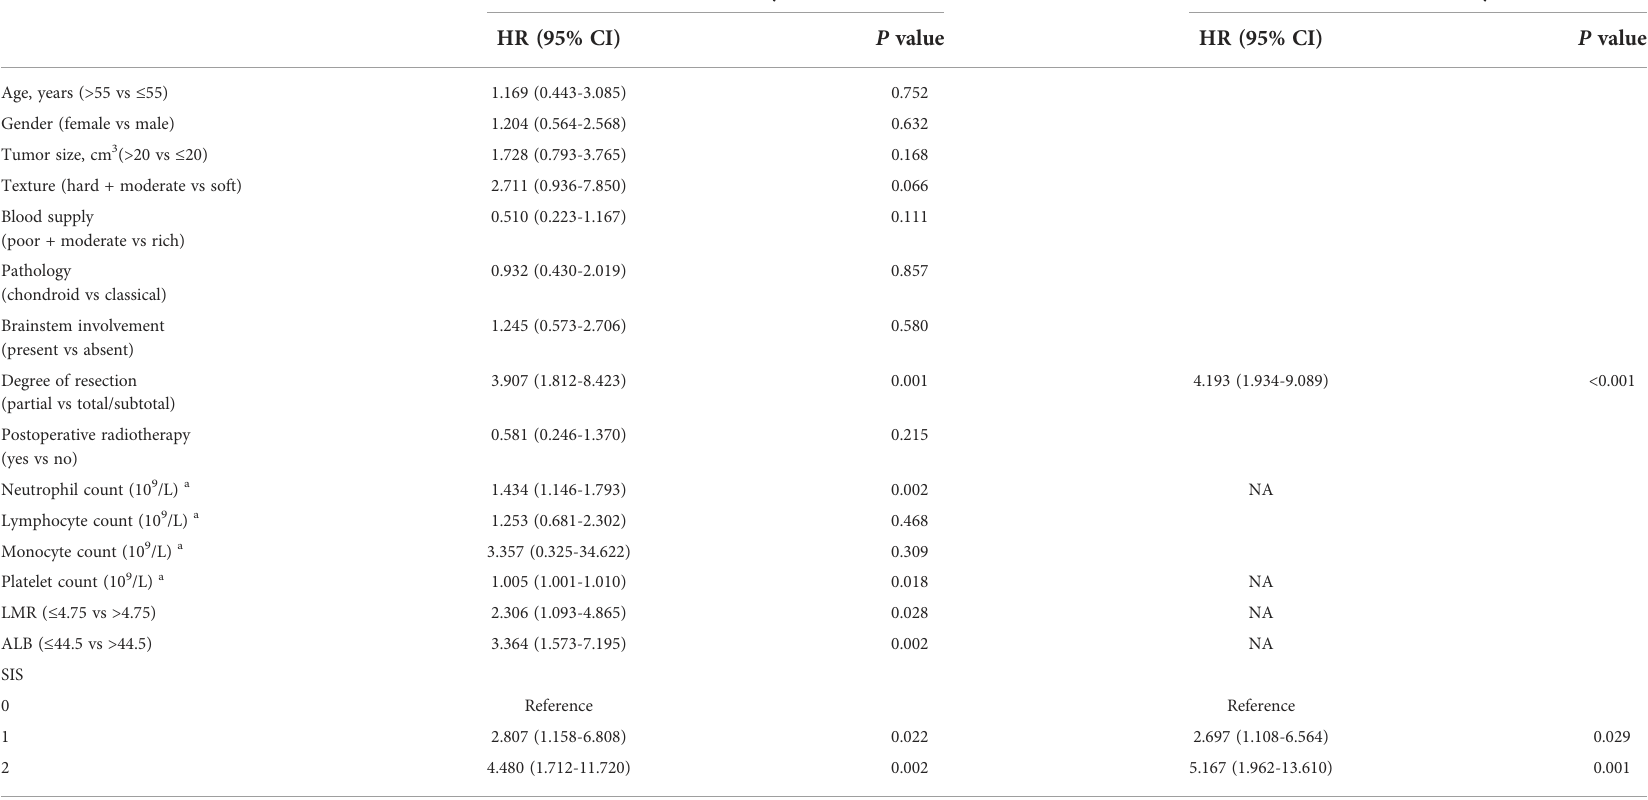
TABLE 3 Univariate and multivariate Cox proportional analysis of OS in the validation